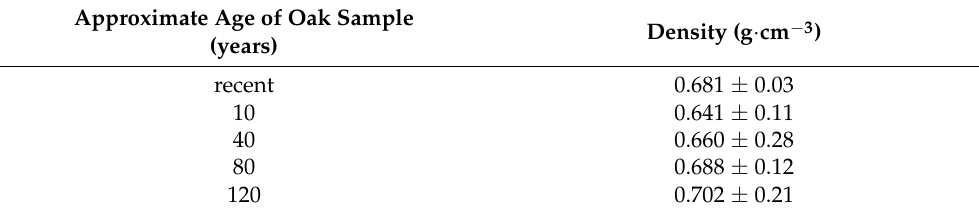
Table 1. The average density of oak wood